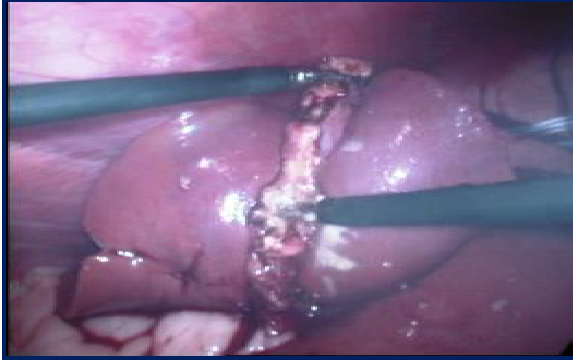
Figure, 2: mucosal cauterization by